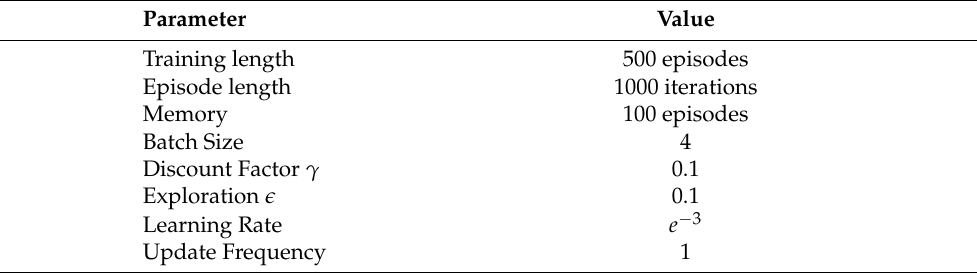
Table 2. RL training